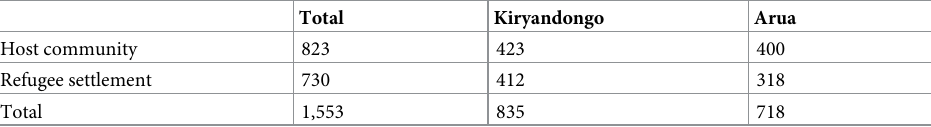
Table 1. Number of respondents by district and refugee status.